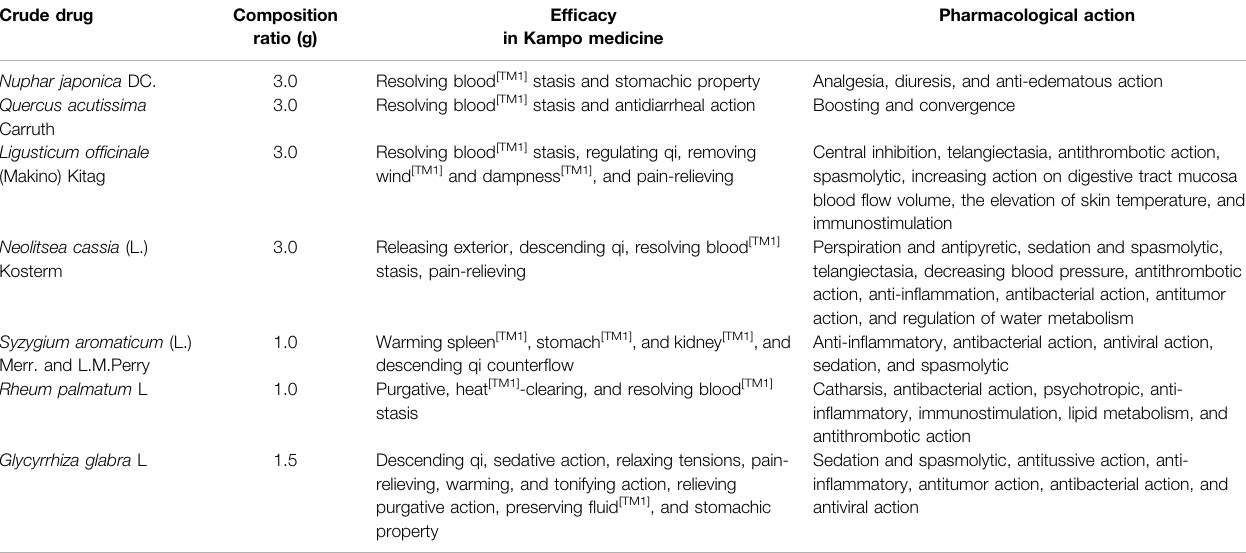
TABLE 1 | Pharmacological action of formulated crude drugs in jidabokuippo. Crude